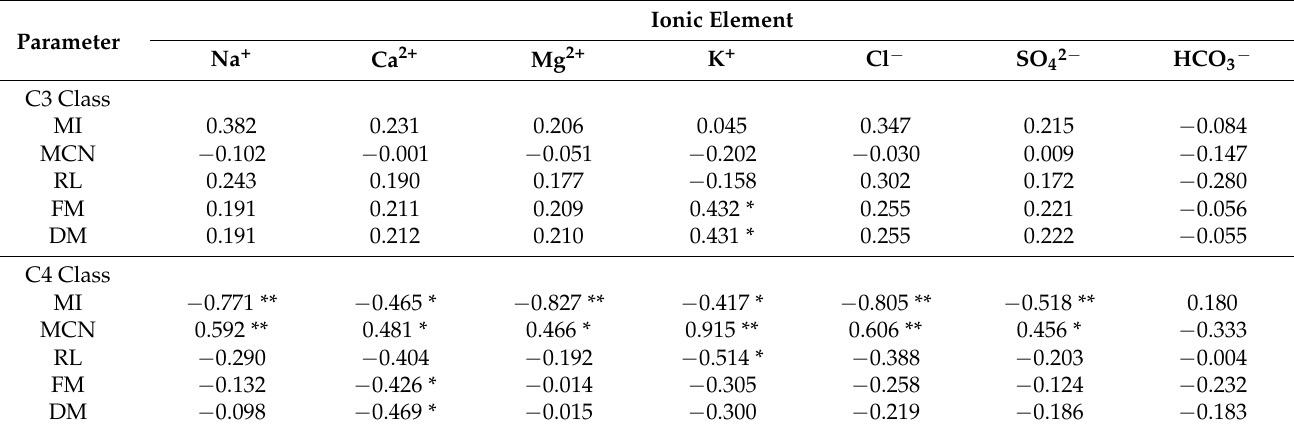
Table 4. Pearson correlation between ionic elements (cations Na + , Ca 2+ , Mg 2+ , and K + and anions Cl − , SO 42 − , and HCO 3 − ), salinity, genotoxicity, and growth parameters. V. faba roots were exposed to C3 (EC: 2.01–2.24 dS m − 1 ) and C4 (EC: 3.46–7.00 dS m − 1 ) water samples during 48